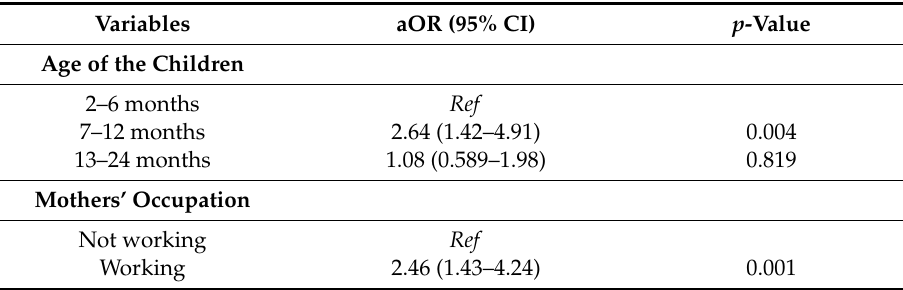
Table 5. Predictor of diarrhea among the